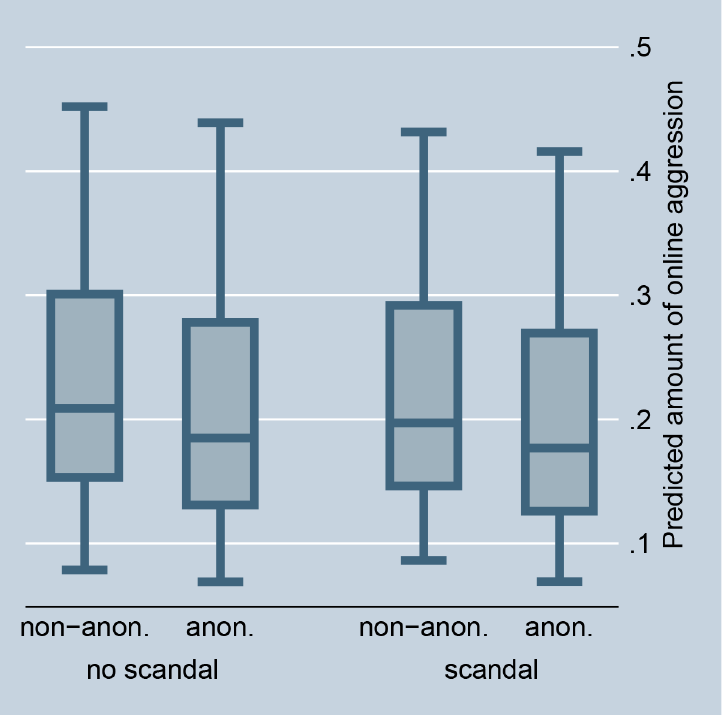
Fig 9. Online aggression dependent on scandal and anonymity (fixed-effects). Predictions of Table 2, Model